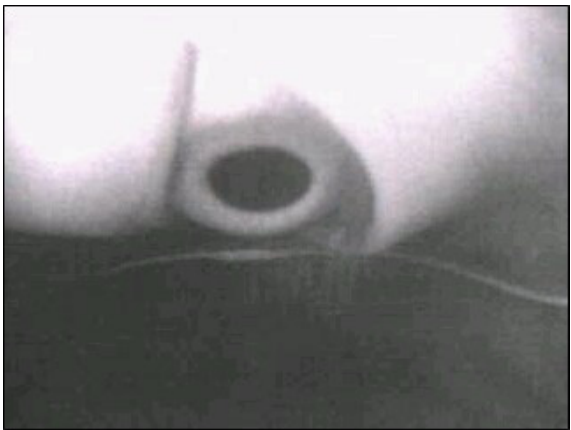
Figure 51. Infrared light image of the eye.